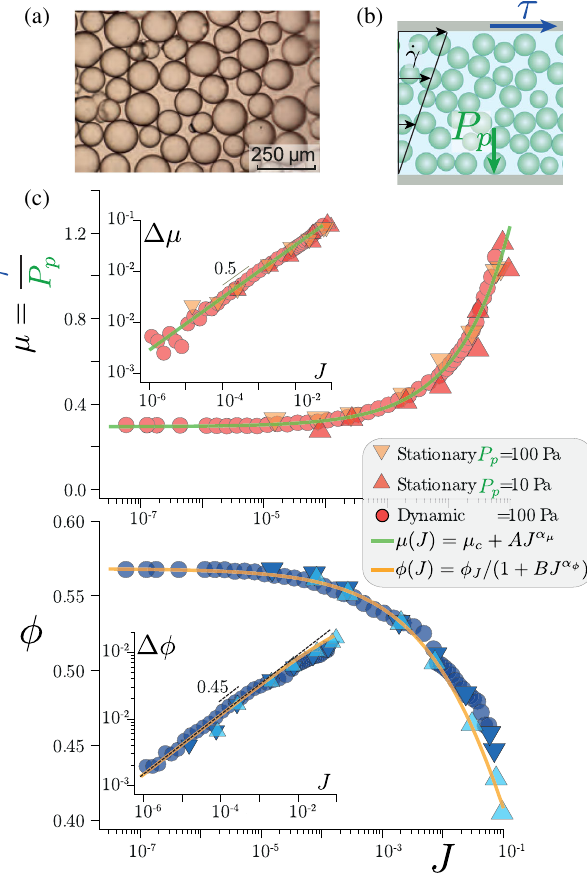
FIG. 2. Capillarytron: Proof of concept on a Newtonian sus- pension. (a) Picture of the PMMA particles of diameter d ≈ 120 μ m. (b) Relevant variables to access the frictional rheology: shear stress τ , particle pressure P , and shear rate _ γ . p (c) Frictionalrheological laws.Top:suspension friction coefficient μ ¼ τ =P ; bottom: suspension volume fraction ϕ versus viscous p number J ¼ η l _ γ =P , obtained from stationary and quasisteady p “ dynamic ” ramps of shear rate. The data are fitted by μ ð J Þ ¼ μ þ AJ α μ and ϕ ð J Þ ¼ ϕ ¼ 0 . 30 , A ¼ 2 . 99 , = ð 1 þ BJ α ϕ Þ with μ c J c α ¼ 0 . 50 , ϕ ¼ 0 . 57 , B ¼ 1 . 10 , and α ¼ 0 . 45 . Insets: (top) μ ϕ J reduced macroscopic friction coefficient Δ μ ¼ μ − μ and c − ϕ versus J (bottom) reduced volume fraction Δ ϕ ¼ ϕ J